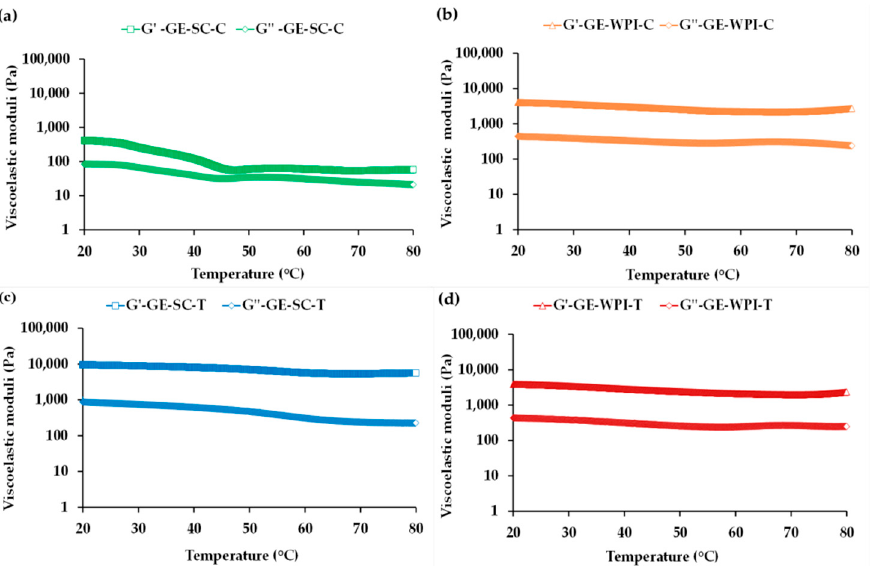
Figure 5. Temperature sweeps of G ′ and G ″ for gelled emulsions (GEs): ( a ) stabilized by SC without added condensed tannins (GE-SC-C); ( b ) stabilized by WPI without added condensed tannins (GE-WPI-C); ( c ) stabilized by SC with added condensed tannins (GE-SC-T); ( d ) stabilized by WPI with added condensed tannins (GE-WPI-T).